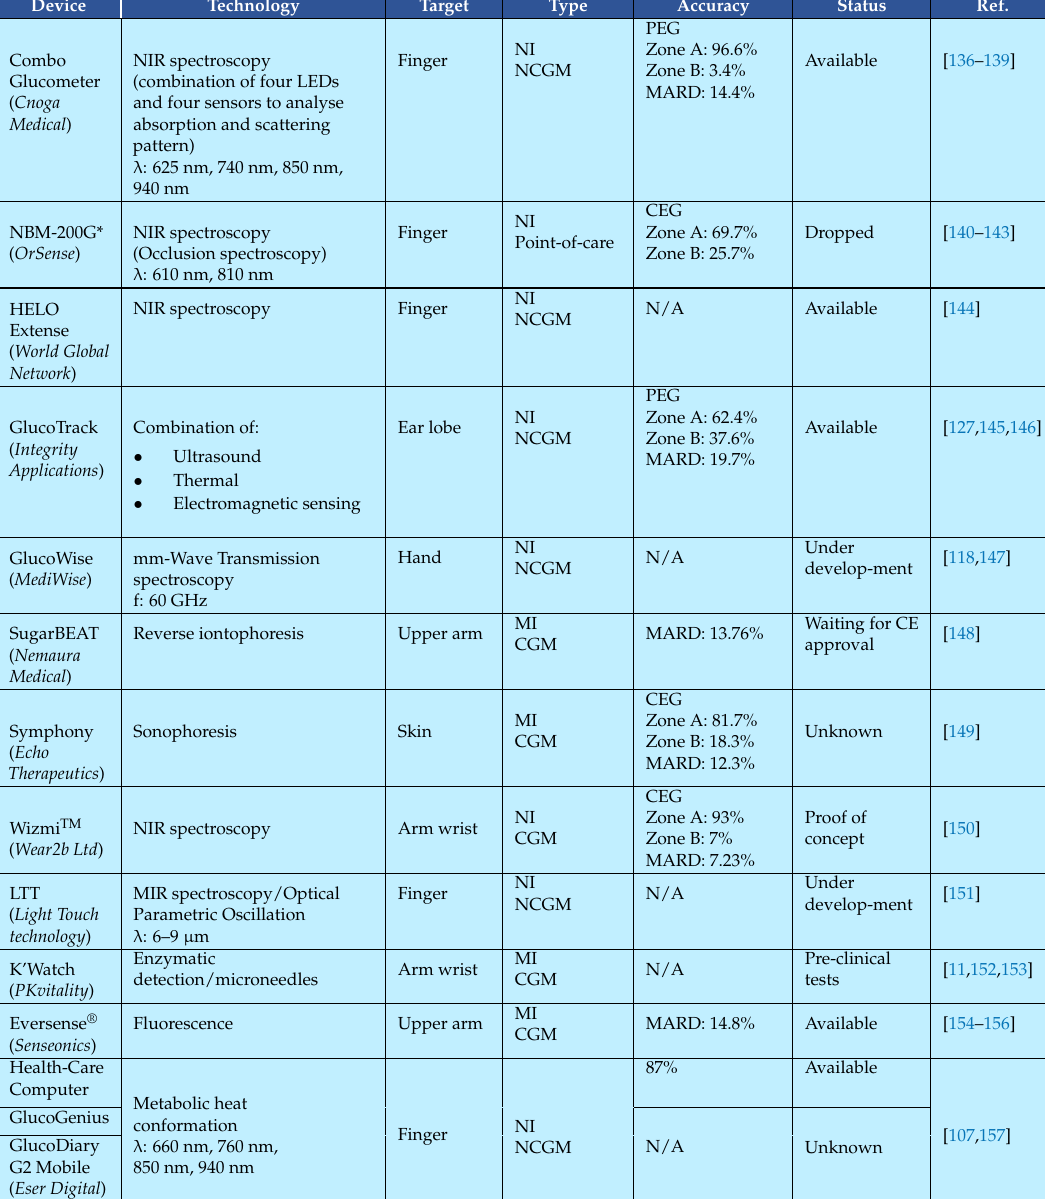
Table 24. Comparison table of minimally-invasive and non-invasive glucose monitoring devices currently available or close to